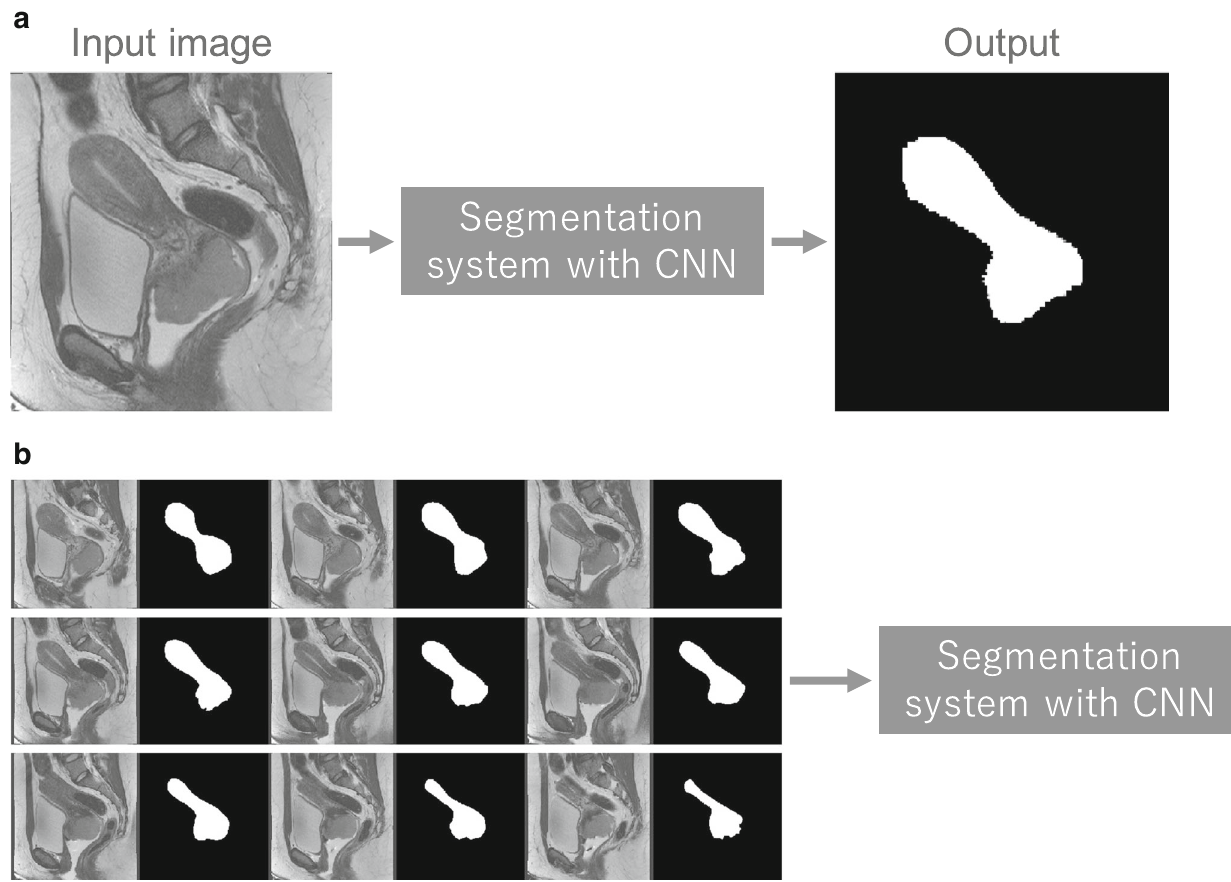
Fig. 12 A schematic illustration of the system for segmenting a uterus with a malignant tumor and representative examples of its training data. a Segmentation system with CNN in deployment phase. b Training data